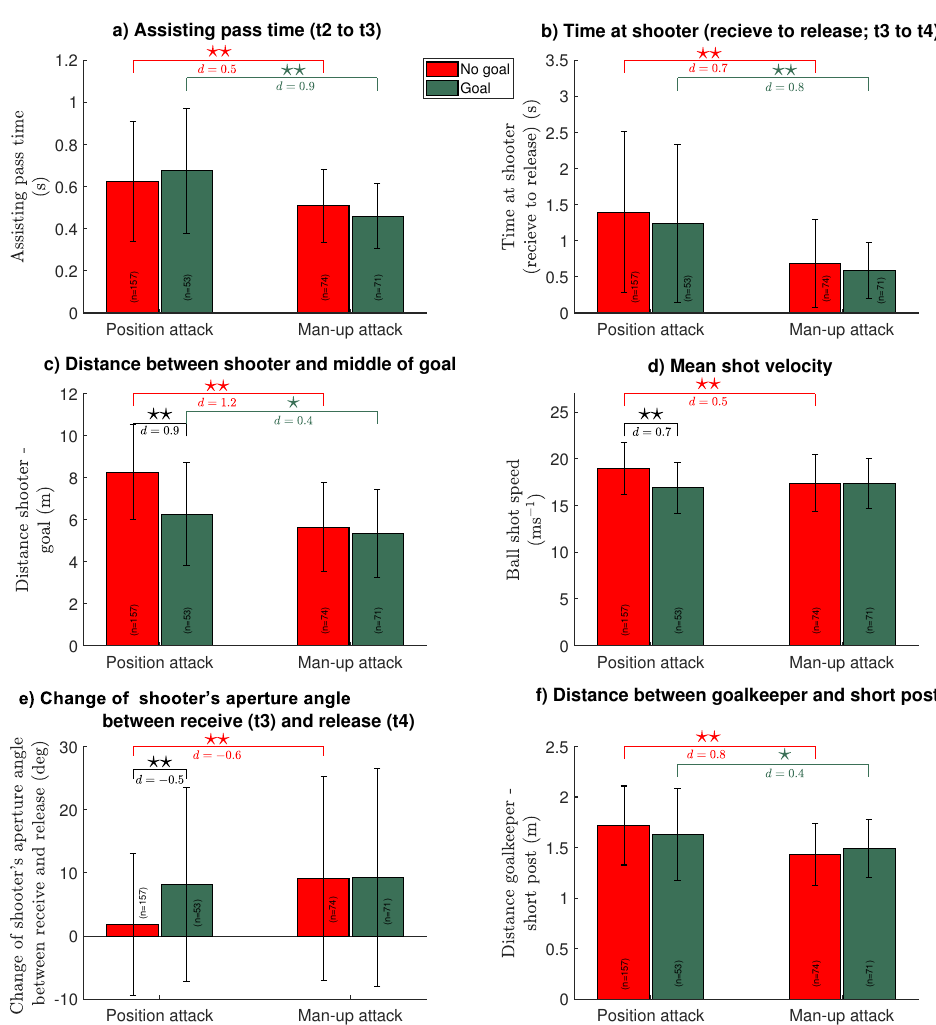
Figure 8. Partial collective tactical analysis of selected characteristics of attacking behavior during goal completion with Cohens’ d and significances ( (cid:63) stands for p < 0.05 and (cid:63)(cid:63) for p < 0.01), separated into positional and man-up attack including following conditions: (1) drive shot or bounce shot, (2) free shot, (3) direct and feint shots and (4) without shot